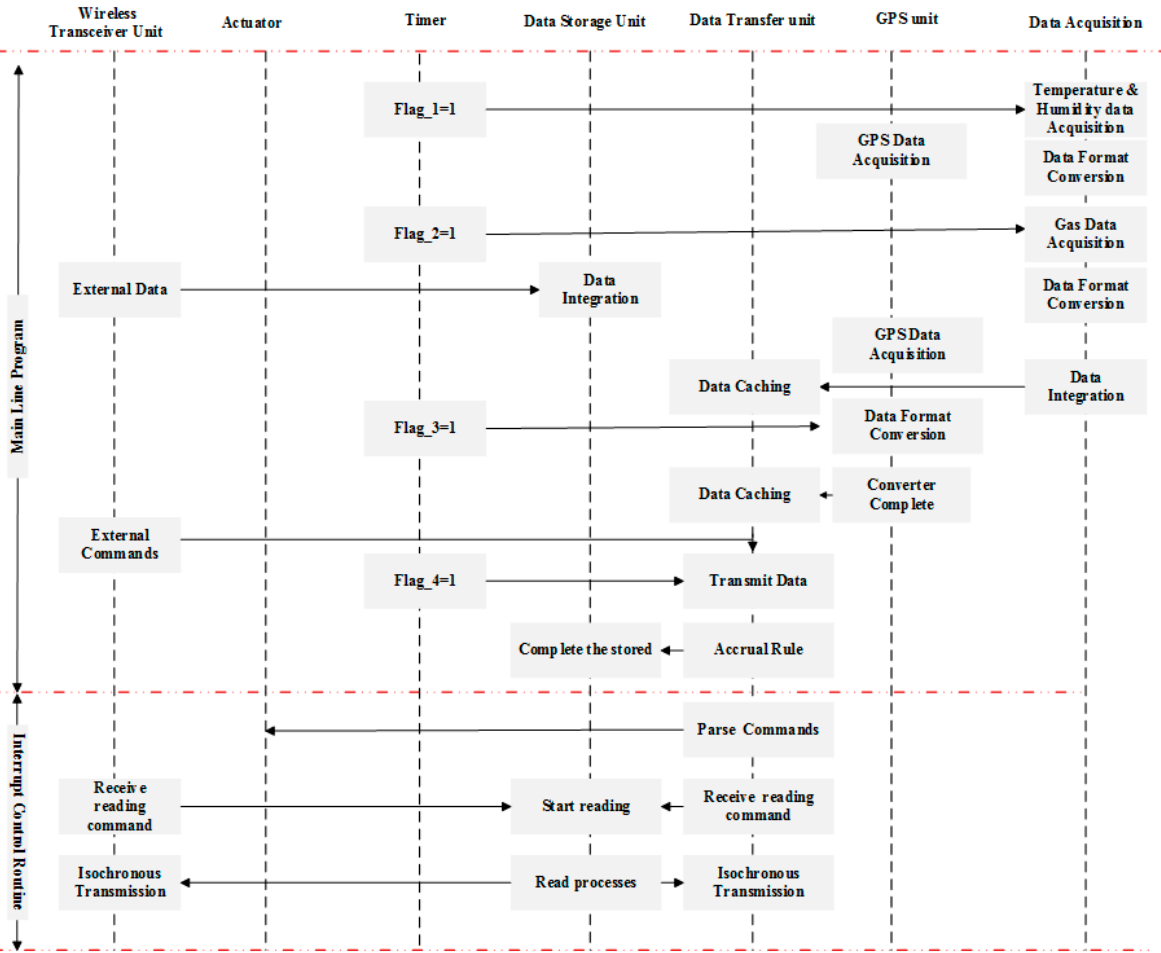
Figure 5. Main line program of the multi-parameter information acquisition and fusion Device.